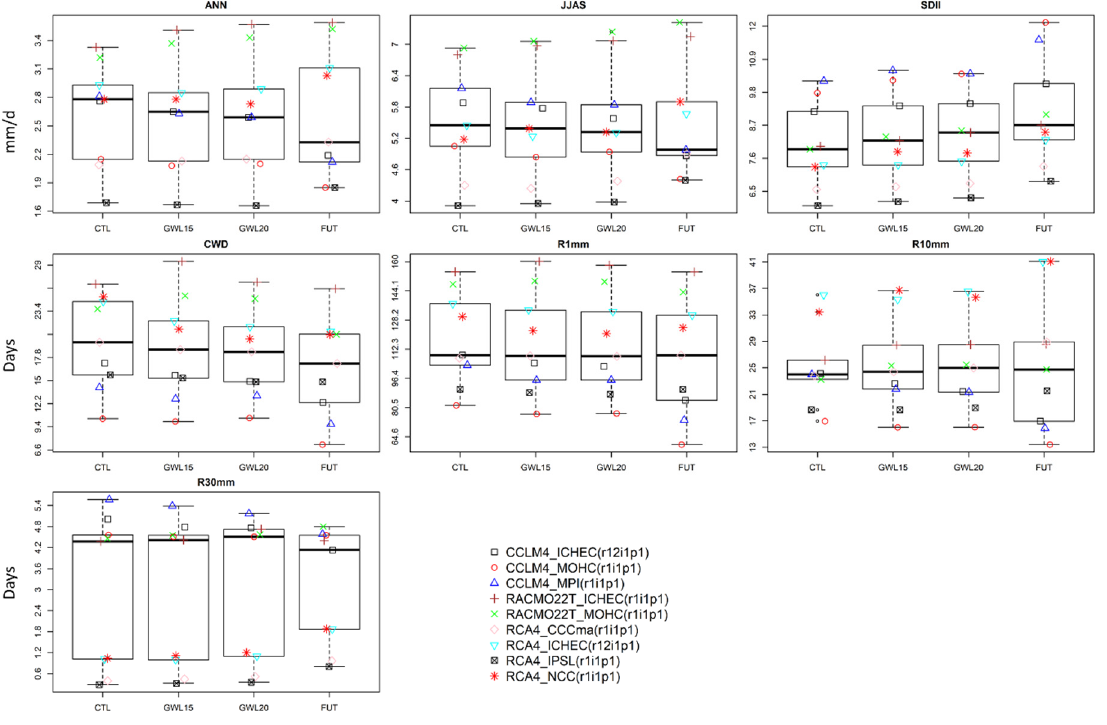
Figure 4. Future precipitation changes over the WA-N region under GWL15, GWL20, and FUT, respectively, compared to the 1976–2005 control period (CTL). Boxplots were plotted using top-performing model runs determined in Section 3.1, using climate projections under the RCP 8.5 scenario.